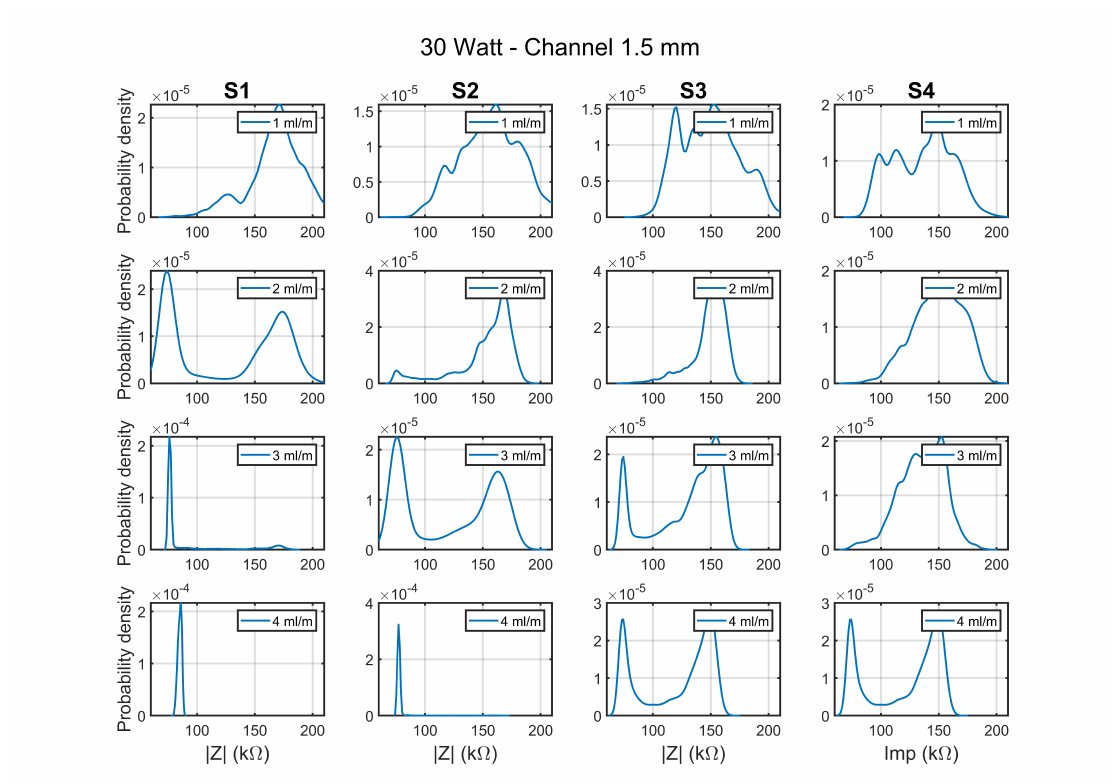
Figure 15. Probability Density of impedance measurements for 30 W experiments on channel